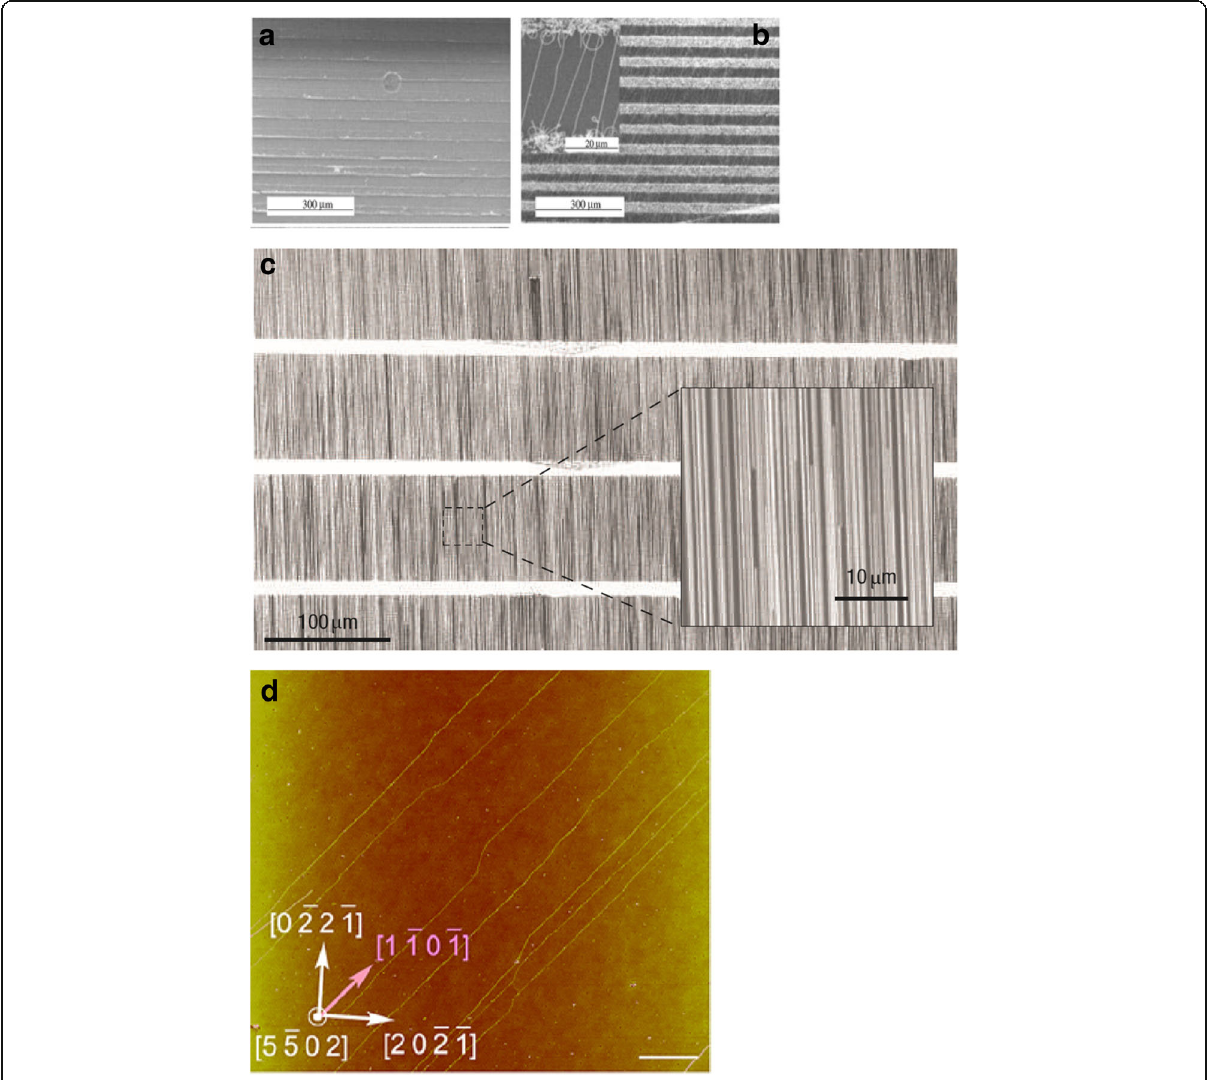
Fig. 29 SEM images of ( a ) catalyst pattern seen on oxide coated Si wafer prior to the growth of SWCNTs. Adapted from [202]. b Long, well-oriented SWCNTs grown using fast-heating growth process with Fe/Mo nanoparticles, CO/H 2 900 °C for 10 min. Inset shows the magnified image of the SWCNT arrays formed. Adapted from [202]. c Well aligned arrays of SWCNTs (~5 SWCNTs μ m − 1 ) formed by CVD growth on a ST-cut quartz substrate. Adapted from [207]. d AFM image of aligned SWCNTs grown on r-plane (1 1 0 2) crystalline surfaces of sapphire. Adapted from